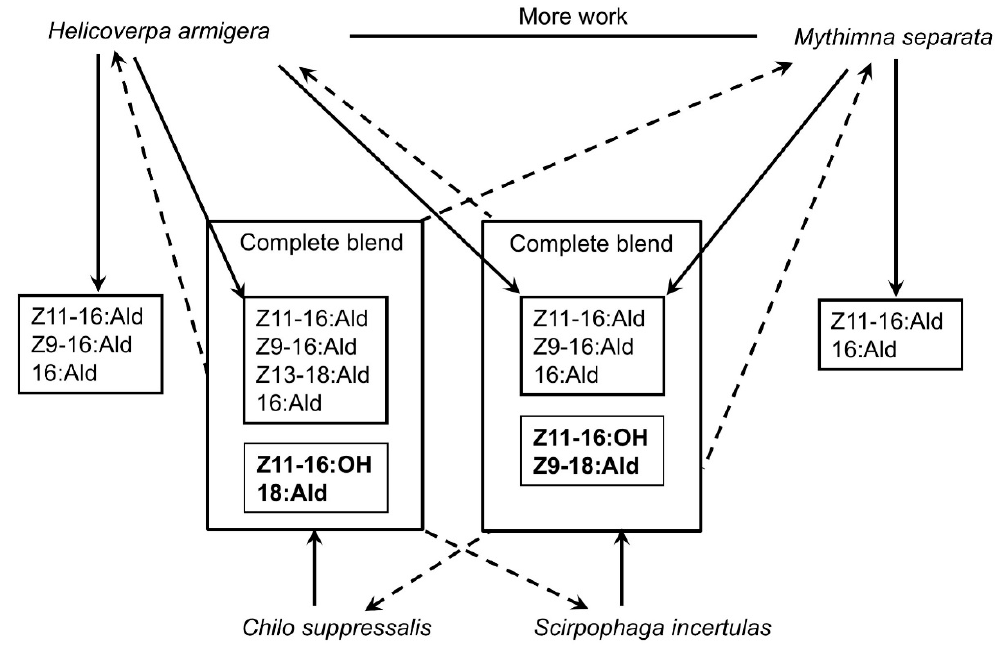
Figure 9. The diagram of the relationship between minor components and species specificity. Solid arrow means attractiveness. Dotted arrow means inhibition of minor components for species specificity.